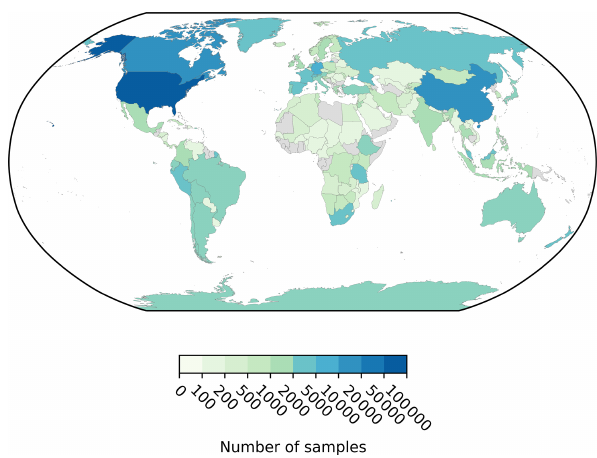
Figure 2. Number of samples (of any type) from each country. Countries in gray have no samples currently stored in the database. Ocean samples are not included in counts. Note that the segmented color scale is not